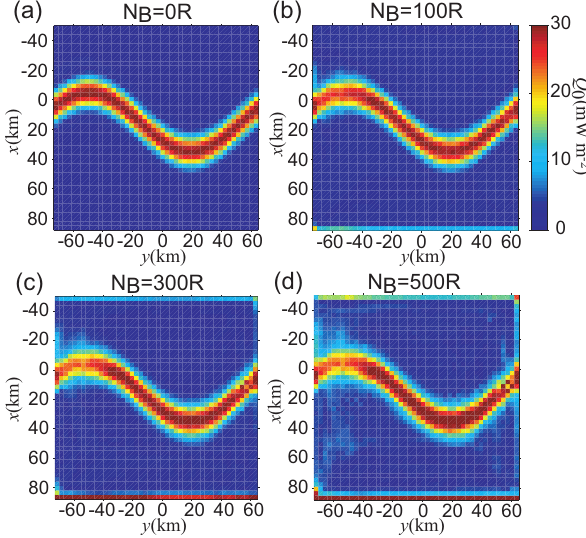
Fig. 5. The dependence of reconstructed total energy flux ( Q 0 ) on noise. Background noise of (a) 0R, (b) 100R, (c) 300R, and (d) 500R has been added to the auroral images for all five ALIS stations.